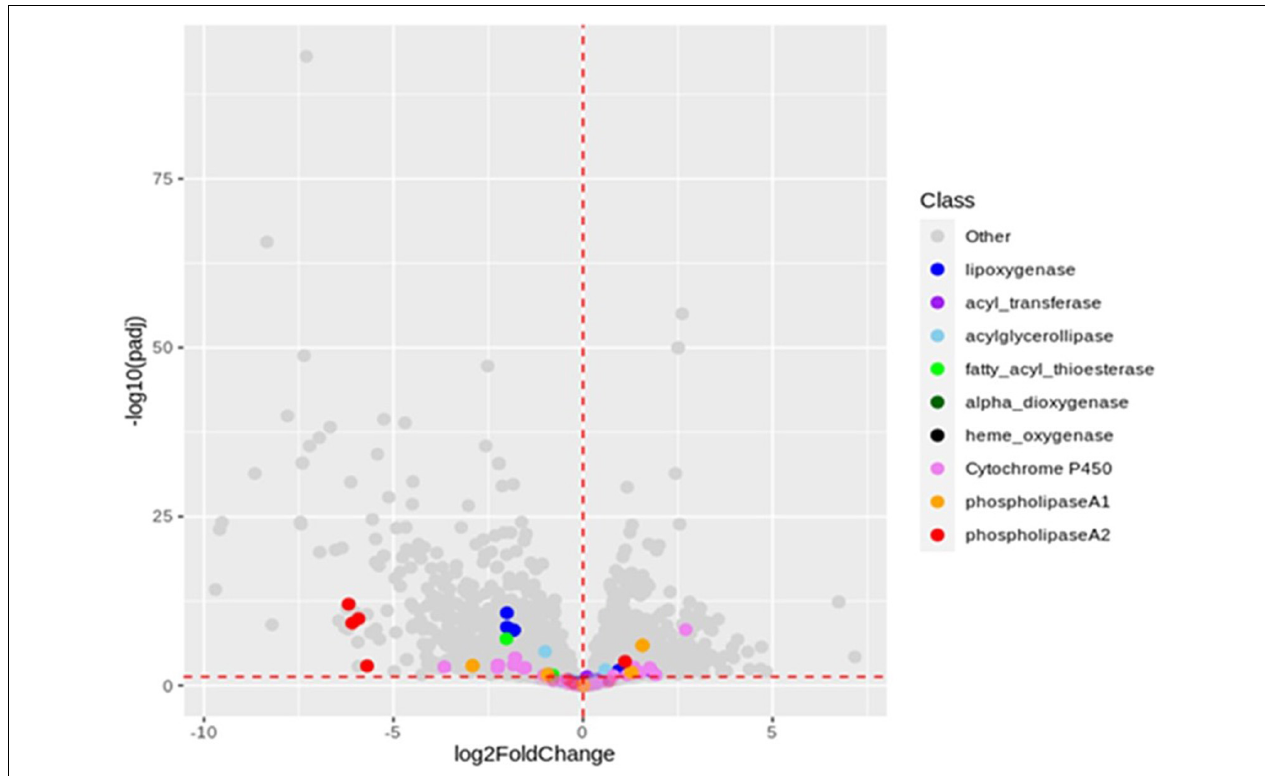
FIGURE 2 | Volcano plot of X vs. H comparison. X-axis: log 2 of genes fold change. Y-axis: − log 10 of the adjusted p -value. The vertical red dashed line is set on x = 0, separating downregulated genes (left side) from upregulated (right side). The horizontal red dashed line is set on y = − log 10 0.05, as a threshold for statistically significant genes. The gene names reported in the volcano plot are filtrated from the RNA-seq data available in the de novo.cnag.cat Olea europea directory (https://denovo.cnag.cat/olive_data?fid~=~161#block-likable-page-title). The annotation is carried out by gene ontology guidelines as reported in Giampetruzzi et al., 2016. Starting from the protein annotation dataset, we design a subset by functional category to find gene’s transcripts involved in the fatty acid metabolism, including the hypothetical